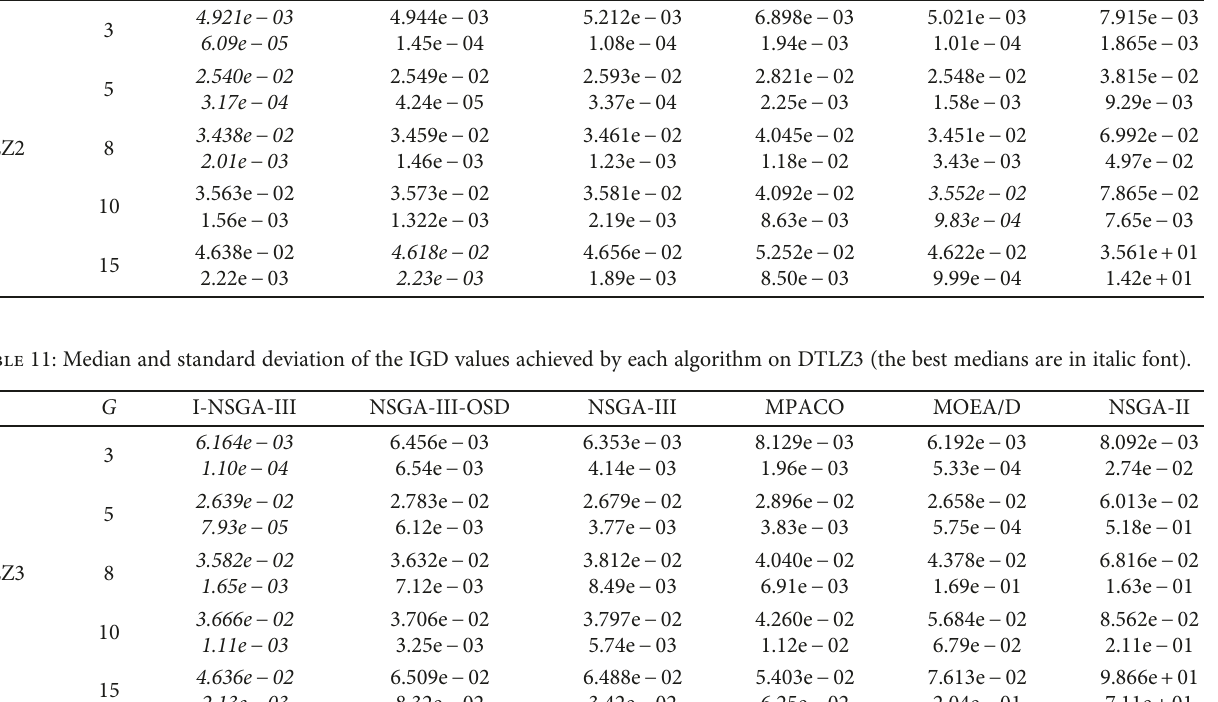
Table 10: Median and standard deviation of the IGD values achieved by each algorithm on DTLZ2 (the best medians are in italic font). G